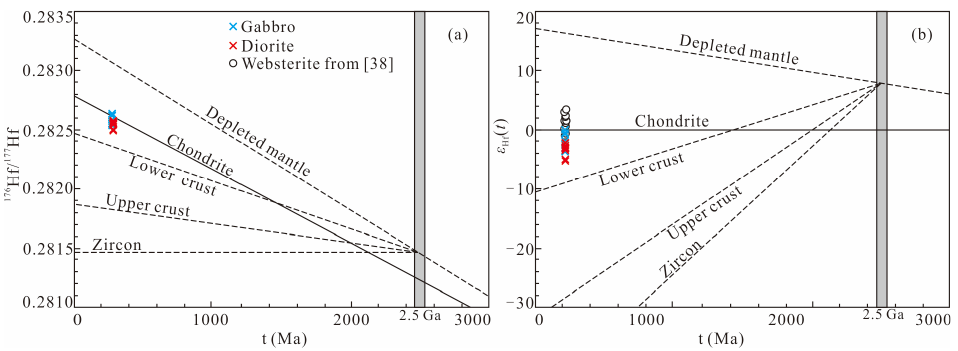
Figure 9. ( a ) t(Ma) versus 176 Hf/ 177 Hf and ( b ) t(Ma) versus ε Hf ( t ) diagrams of zircon from gabbro and diorite (modified after [55]). The data on websterite in the same intrusion were cited from [38].